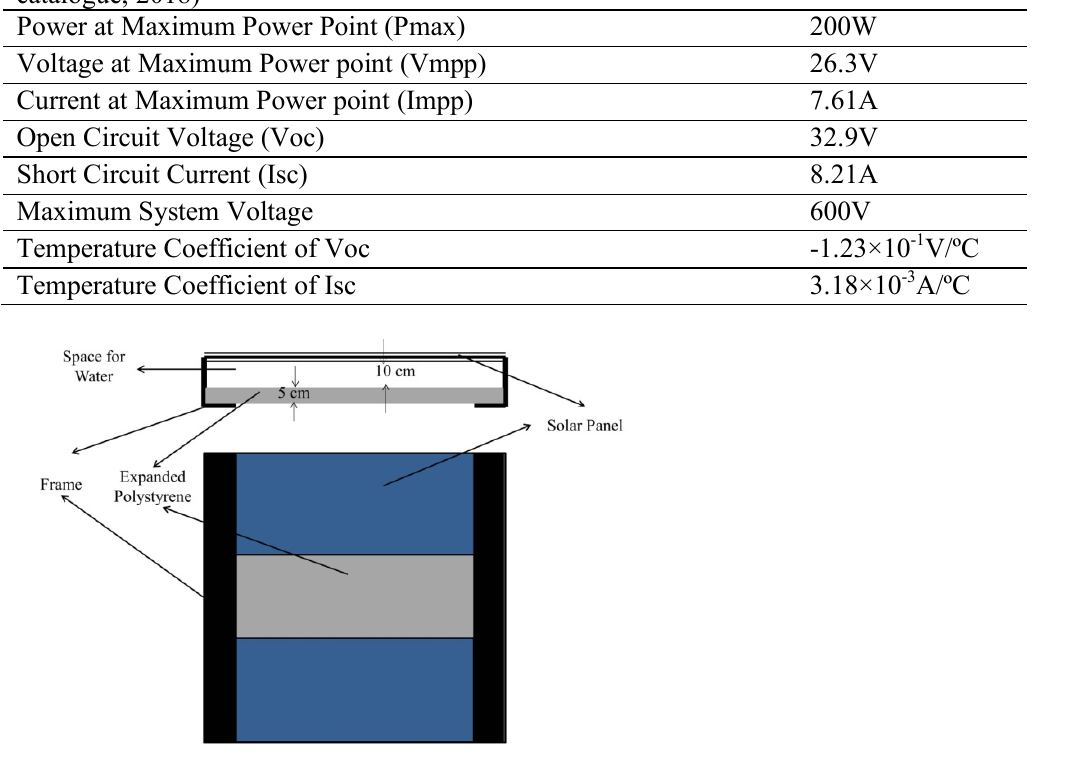
Table 2. Electrical Performance of photovoltaic cell under Standard Test Conditions (KC200GT